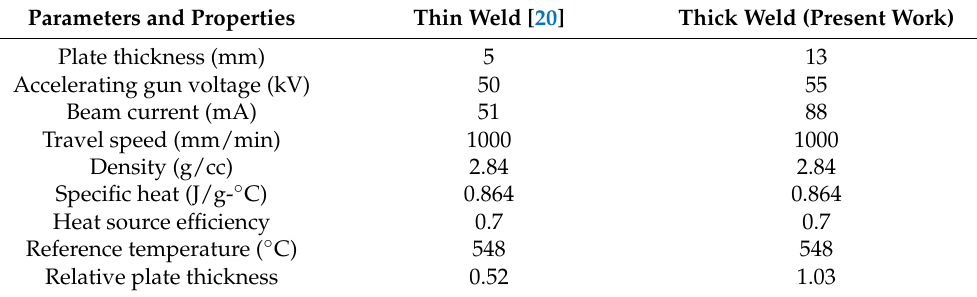
Table 4. Comparison of heat flow in thin and thick